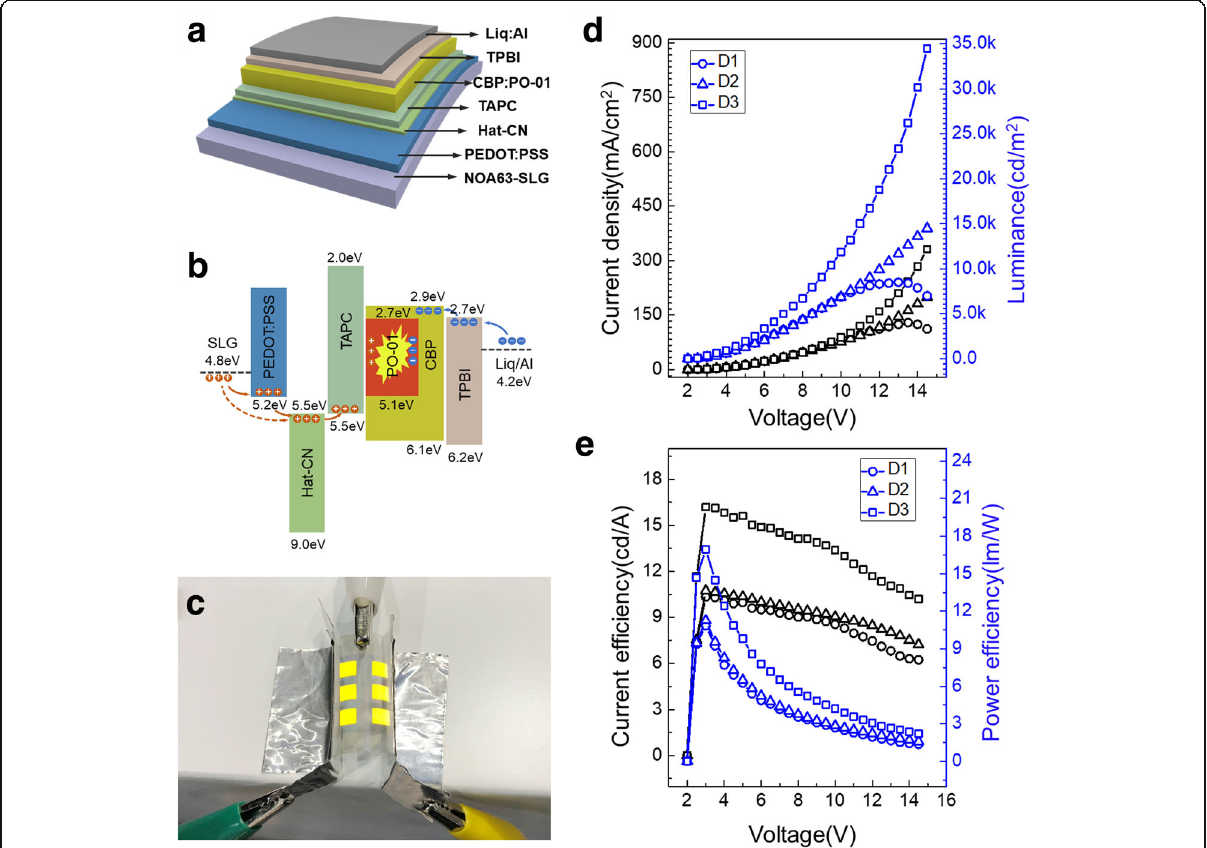
Fig. 5 a Schematic device structure of the FOLED. b Work function of SLG and HOMO/LUMO energy level of the FOLED components. Device characteristics of D1(based on SLG/HRA/PET), D2(based on SLG/ NOA63), and D3(based on PEDOT:PSS/SLG/NOA63). c J-V-L characteristics. d Current efficiency and power efficiency-voltage characteristics. e Photograph of the FOLED based on SLG/NOA63 (size 4 mm × 4.5 mm ×